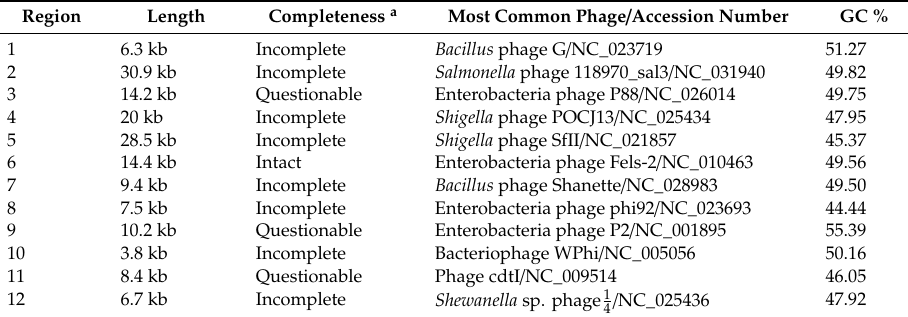
Table 3. Predicted phages detected in the EC121 genome.